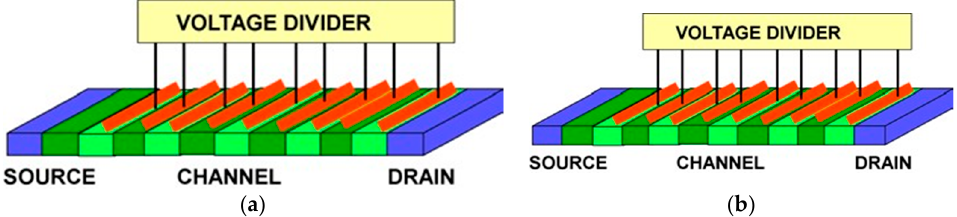
Figure 6. Plasmonic boom: variable electron sheet density ( a ) and variable width structures ( b ).